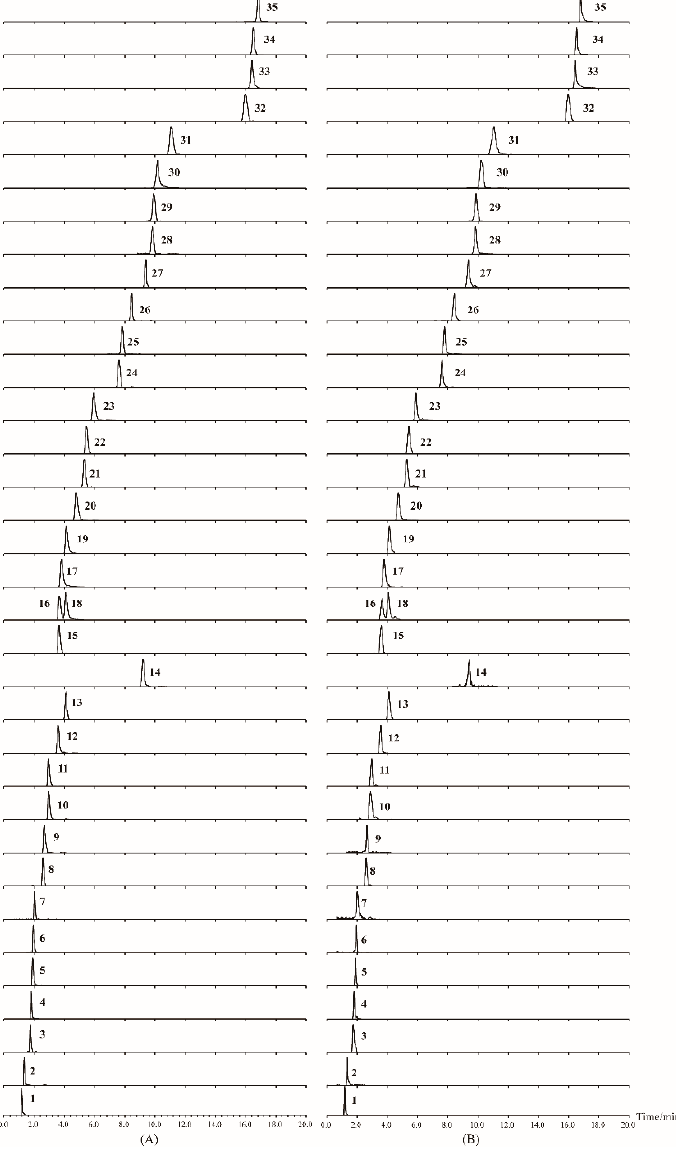
Figure 1. UHPLC-MS-MS chromatograms of mixed standards ( A ) and sample ( B ) for the 35 analytes